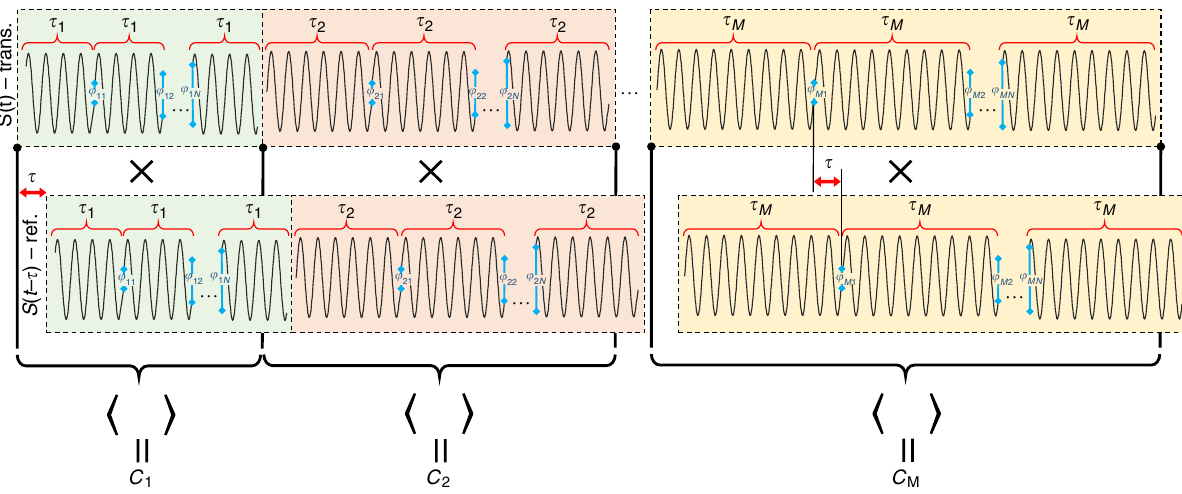
Fig. 2 Illustration of the proposed detection method. The transmitted signal consists of a CW wave with a phase that is switched randomly every τ m seconds, corresponding to opening a coherent window of length c τ m . If a target exists within the coherent window, the re fl ected signal will be delayed by time τ and can be divided into two parts — the fi rst is of duration ð τ m (cid:3) τ Þ , which is correlated with the still transmitting signal (i.e., the same phase), the other part is of duration τ and is uncorrelated with the transmitting signal. By switching the phase N times and averaging the product of the re fl ected and transmitting signal over a window of length N τ m , the cross-correlation C m , which is the cross-correlation for coherence time interval τ m , is measured. The cross-correlation averages to 0 if the target is not within the coherence length. For a target within the coherent window, however, the average increases as the target becomes closer. By increasing the coherent window and repeating the process, the cross-correlation as a function of coherence length can be obtained (see Fig. 3).